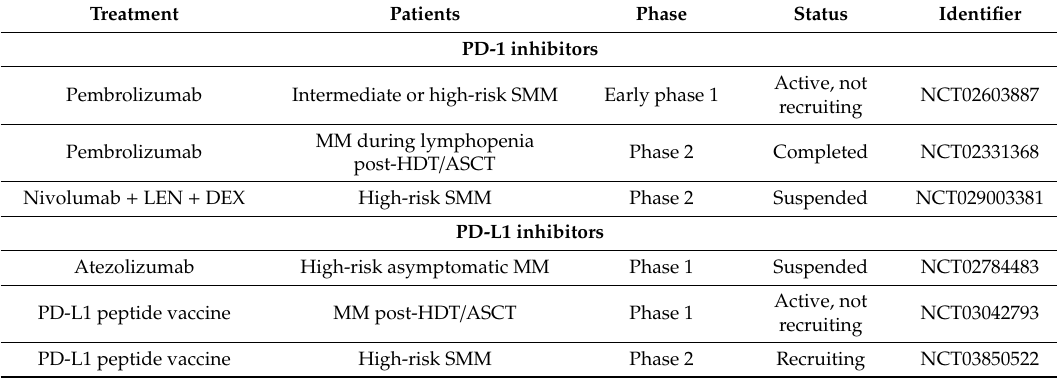
Table 3. Clinical trials using blockade of the PD-L1 − PD-1 pathway to prevent disease progression in multiple